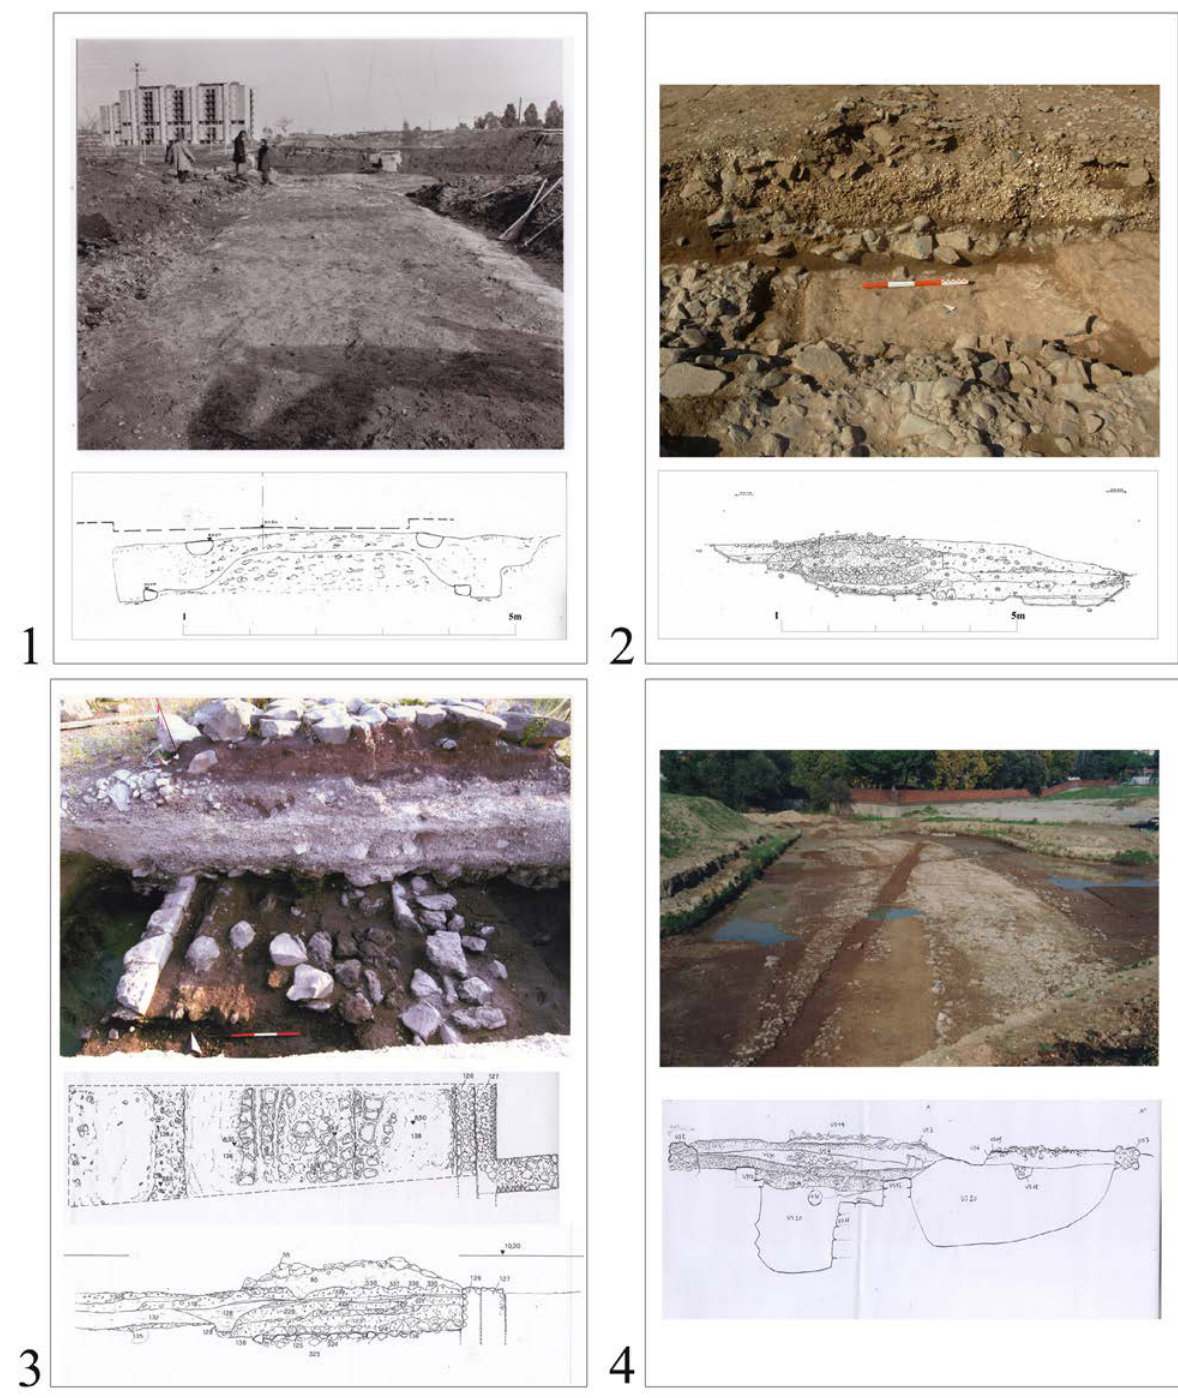
Figure 3. (1) Intersection of the Via Pontina road with the Via degli Eroi di Cefalonia road: photo and section of street levels; (2) inter- section of the Via Pontina road with the Via di Decima road: photo and section of street levels; (3) basin of the Fosso di Vallerano (loc. Castellaccio): photo, planimetry and section of street levels; 4. basin of the Fosso di Vallerano: photo and section of street